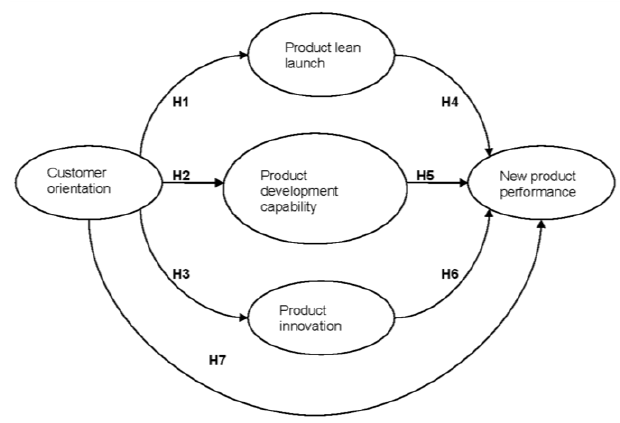
Figure 1: Conceptual